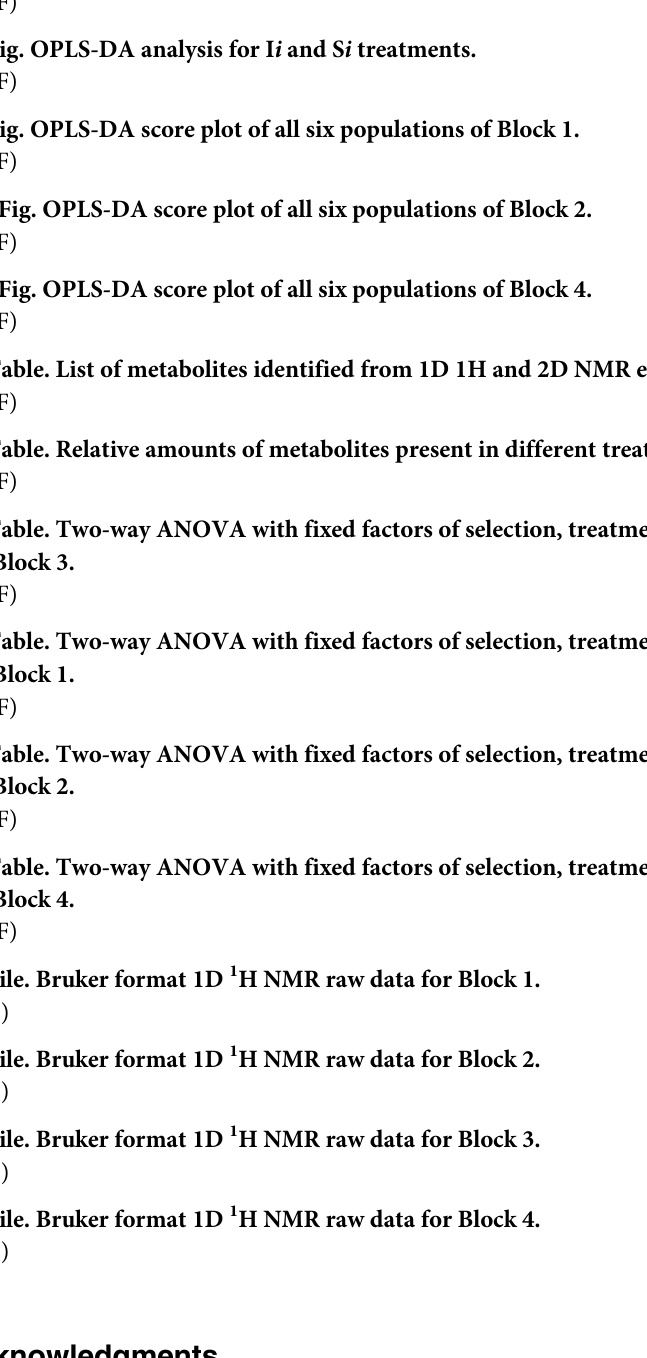
S7 Fig. OPLS-DA analysis for I s and S s treatments. (PDF) S8 Fig. OPLS-DA analysis for I i and S i treatments. (PDF) S9 Fig. OPLS-DA score plot of all six populations of Block 1. (PDF) S10 Fig. OPLS-DA score plot of all six populations of Block 2. (PDF) S11 Fig. OPLS-DA score plot of all six populations of Block 4. (PDF) S1 Table. List of metabolites identified from 1D 1H and 2D NMR experiments. (PDF) S2 Table. Relative amounts of metabolites present in different treatments. (PDF) S3 Table. Two-way ANOVA with fixed factors of selection, treatment and their interaction for Block 3. S4 Table. Two-way ANOVA with fixed factors of selection, treatment and their interaction for Block 1. S5 Table. Two-way ANOVA with fixed factors of selection, treatment and their interaction for Block 2. S6 Table. Two-way ANOVA with fixed factors of selection, treatment and their interaction for Block 4.